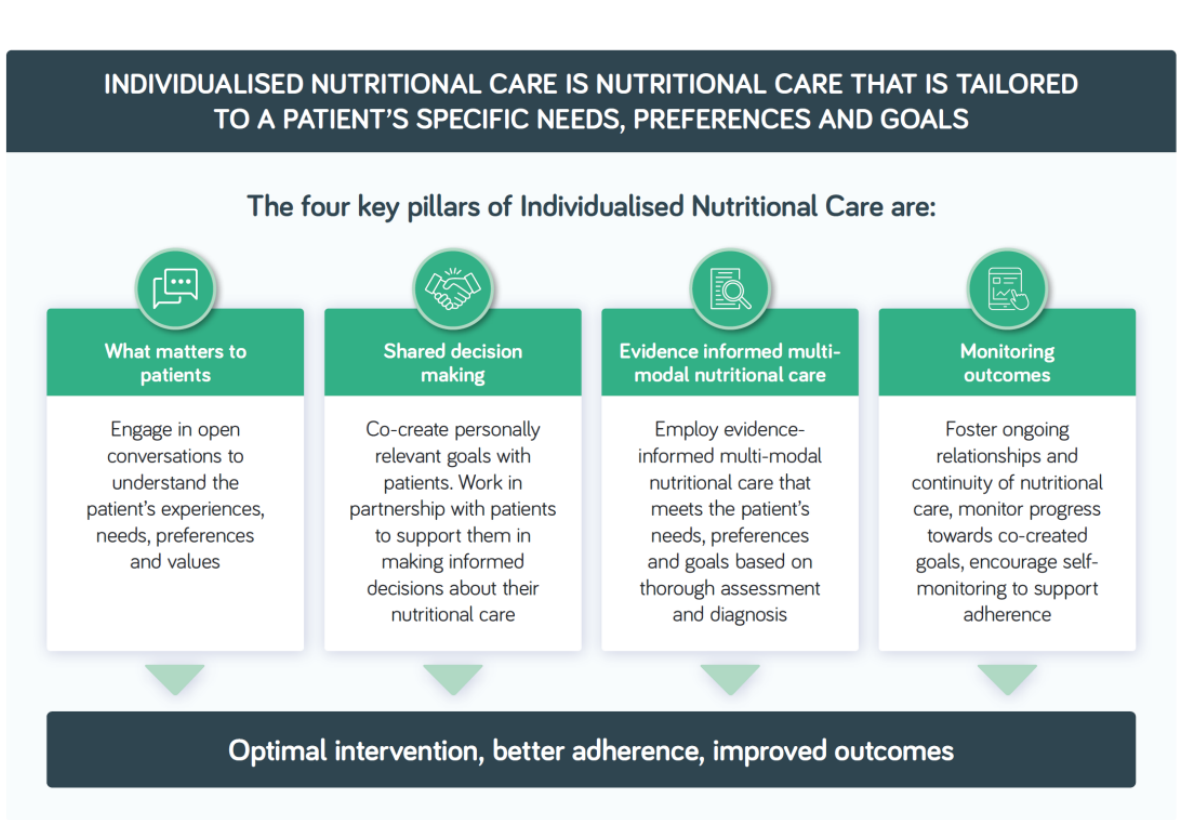
Figure 1. Individualised nutritional care in the management of disease-related malnutrition in